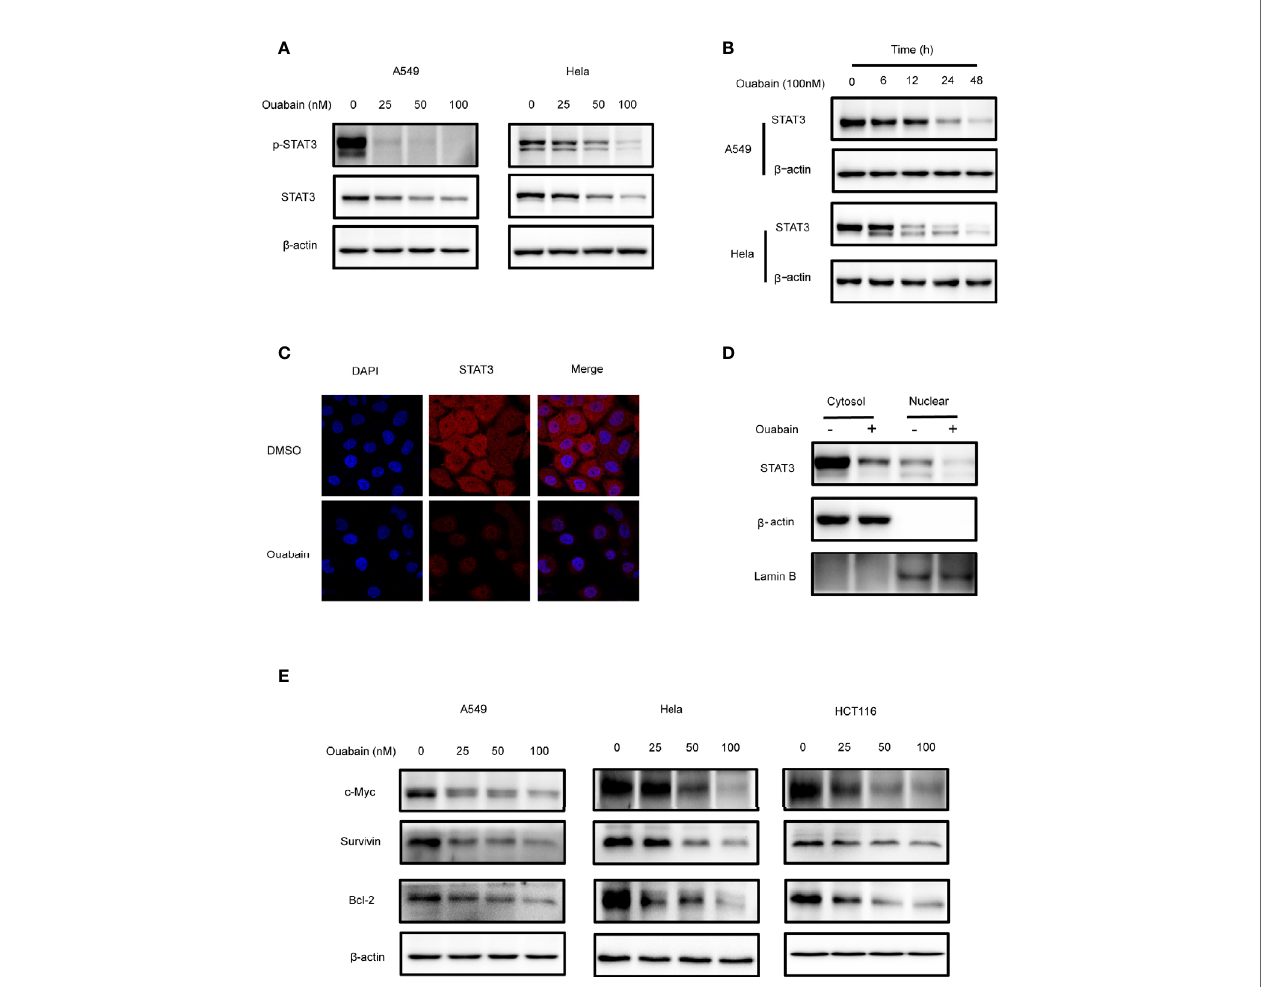
FIGURE 4 | Ouabain downregulated the expression of STAT3. (A, B, E) Cells were incubated with ouabain at the indicated concentrations and time. The expressions of STAT3, p-STAT3, c-Myc, Survivin, Bcl-2 were determined by Western blotting using speci fi c antibodies. (C) Hela cells treated with vehicle or 100 nM ouabain for 24 hours were analyzed by immuno fl uorescence. (D) Cytoplasmic and nuclear extracts from Hela cells treated with ouabain were analyzed by Western blotting using